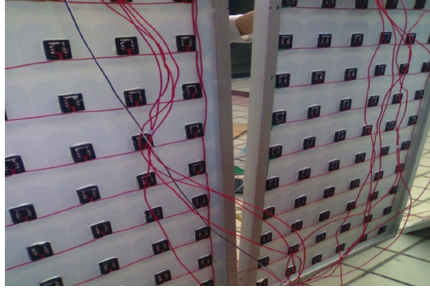
Figure 4: Custom-made solar